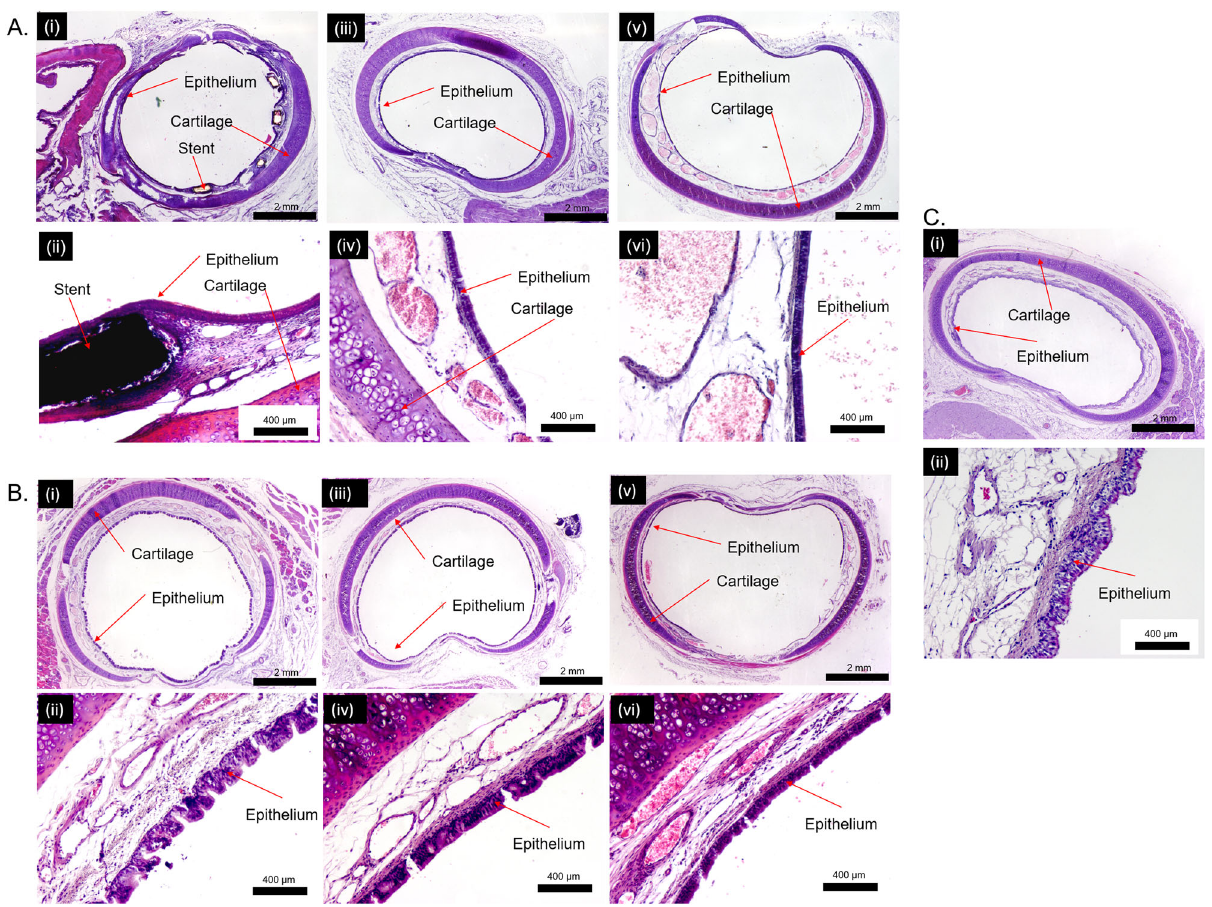
Fig. 4 H&E staining of the stented rabbit trachea. A LZ61-KBMS stent stented trachea at various magni fi cations after (i – ii) 4 weeks, (iii – iv) 8 weeks; (v – vi) 12 weeks, B 316L ss stent stented trachea at various magni fi cations after (i – ii) 4 weeks, (iii – iv) 8 weeks; (v – vi) 12 weeks, C (i – ii) healthy rabbit trachea at two different magni fi